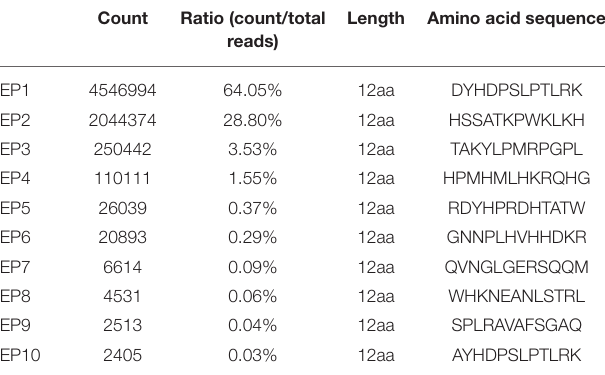
TABLE 4 | The frequencies of the top 10 epitope